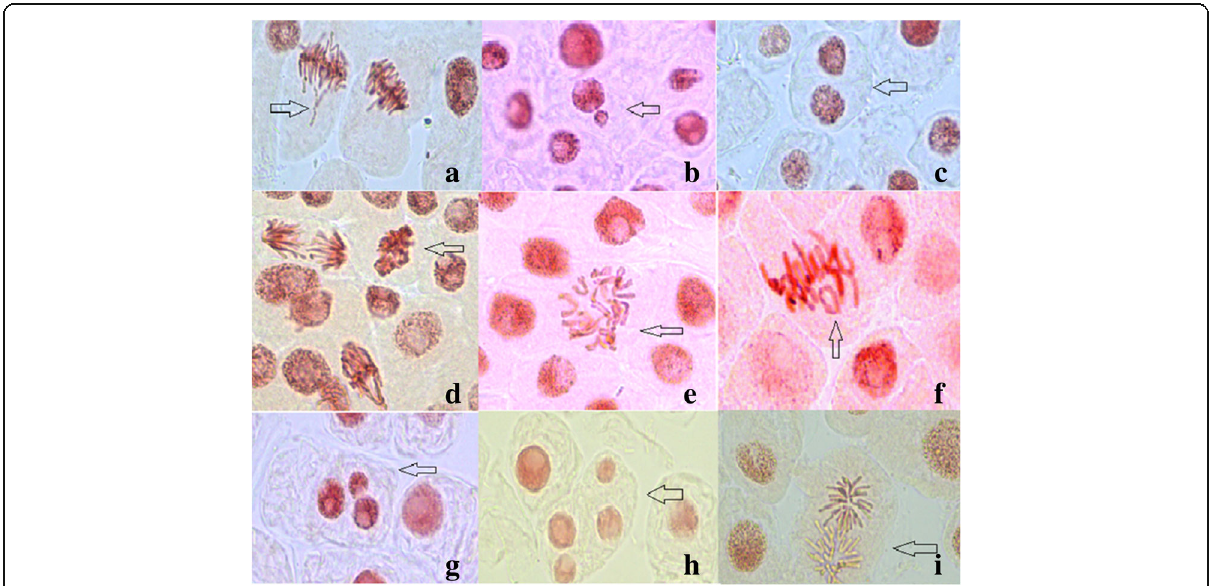
Fig. 6 Chromosome aberrations and mitotic abnormalities induced by the solvent and 5% hydro-alcoholic extract of Juniperus communis L. a – laggards, b – micronucleus, c – binucleated cell, d – stickiness, e – C-mitosis, f – ring chromosome, g , h – multinucleated cells, i – star